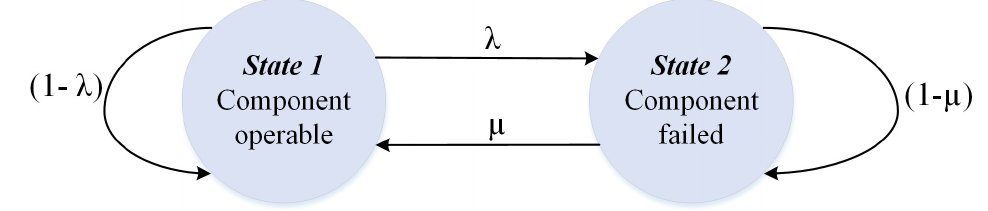
Figure 1. State-space diagram of a repairable